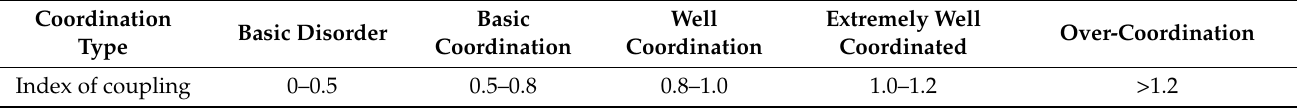
Table 2. Coupled agroecological risk coordination index of WLR in the